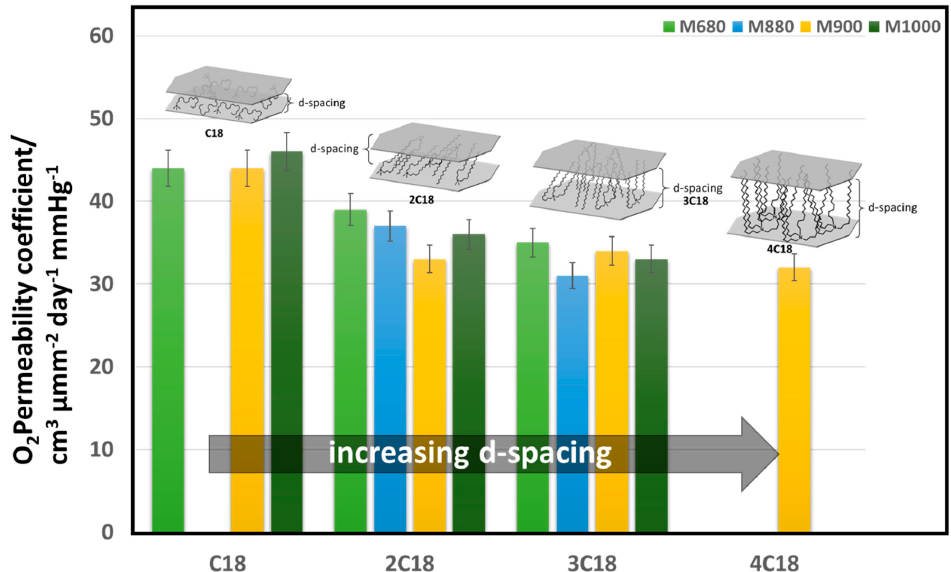
Figure 6. Effect of clay organic modifier on the macroscopic properties of polymer nanocomposites (PNCs). Montmorillonite with CEC/ μ eq g − 1 of 680, 880, 900, and 1000 were chemically modified with trimethyl-(octadecyl)ammonium (C18), dimethyldi(octadecyl)ammonium (2C18), methyl-tri(octadecyl)ammonium (3C18), and tetra(octadecyl)ammonium (4C18) and dispersed within a linear high-density poly(ethylene) (HDPE) matrix [1,55].